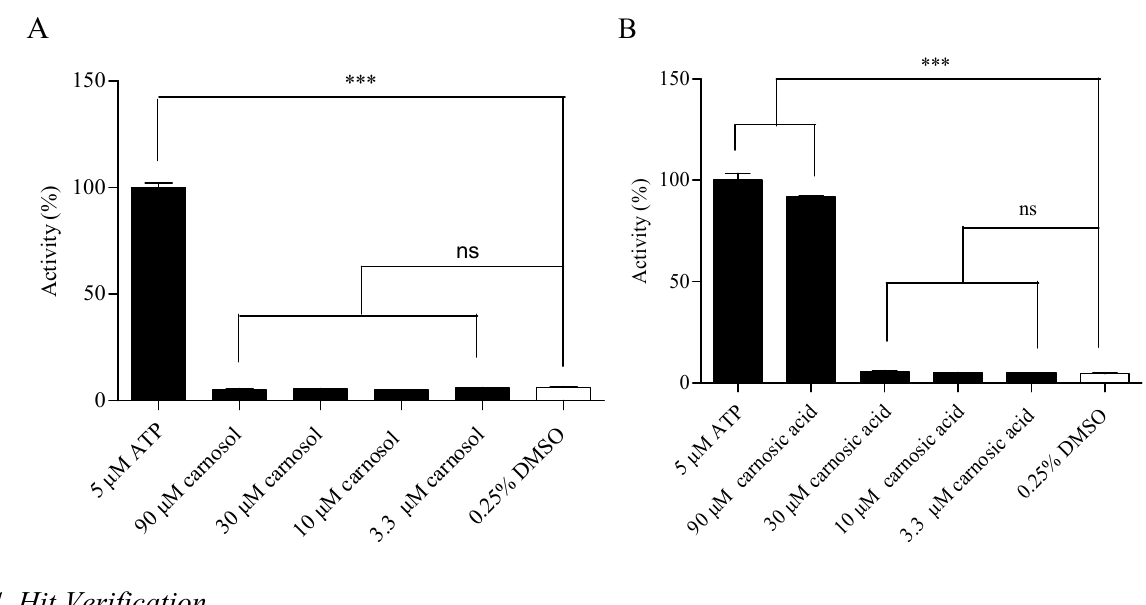
Figure 6. Effect of carnosol ( A ) and carnosic acid ( B ) in HEK293 host cells were evaluated using calcium assay. Five micromoles of ATP and 0.25% DMSO were used as the positive and negative control respectively. Values are means of replicates of three independent experiments ± standard error. Bars with stars are significantly different from the control group (*** p <